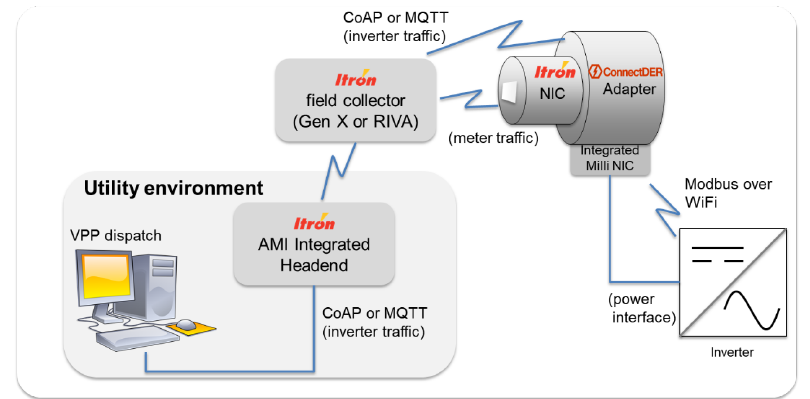
Figure 2. Block diagram of a conceptual system-level architecture for field